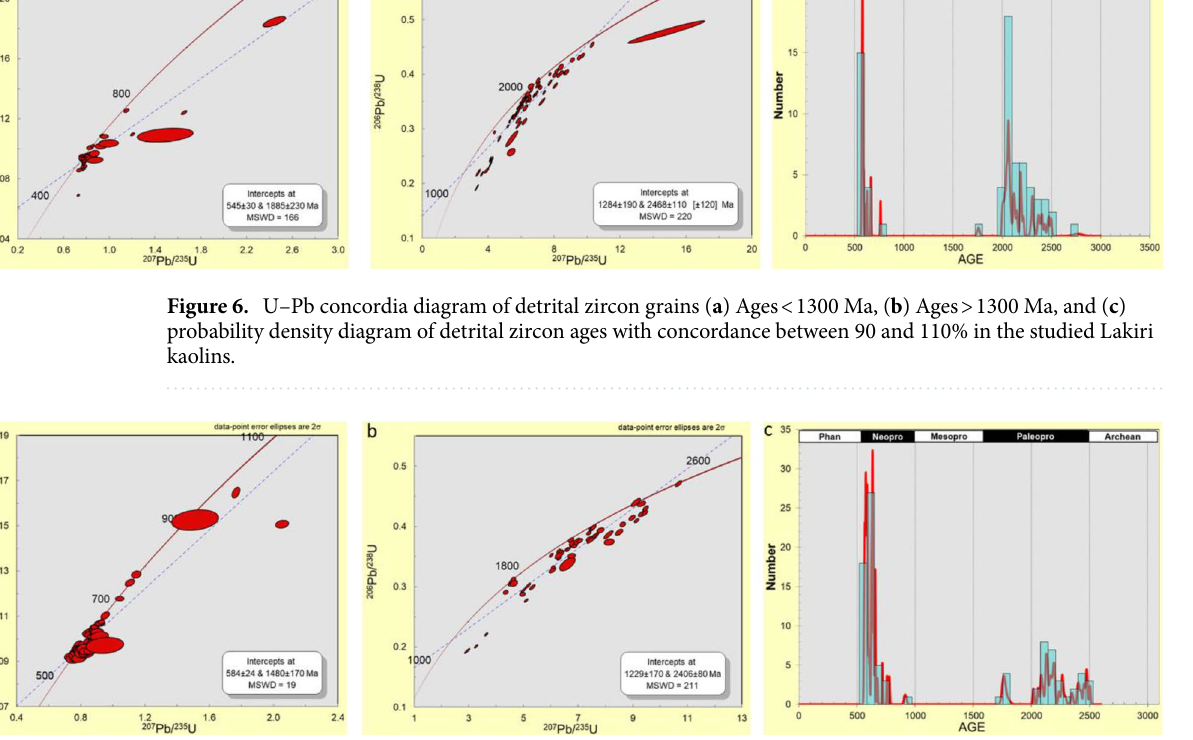
Figure 7. U–Pb concordia diagram of detrital zircon grains ( a ) Ages < 1300 Ma, ( b ) Ages > 1300 Ma, and ( c ) probability density diagram of detrital zircon ages with concordance between 90 and 110% in the studied Eruku